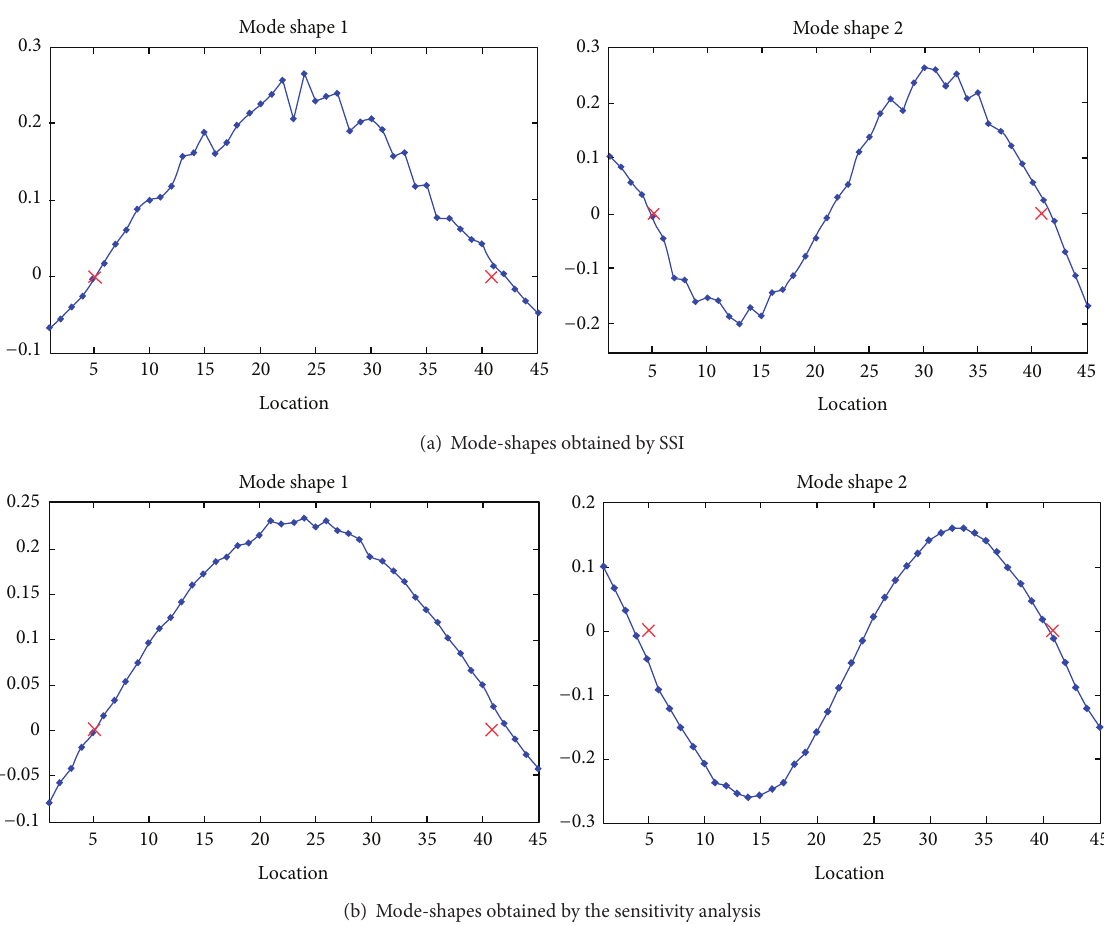
Figure 10: Comparison of mode-shapes obtained by SSI and the sensitivity analysis ( × : position of support).